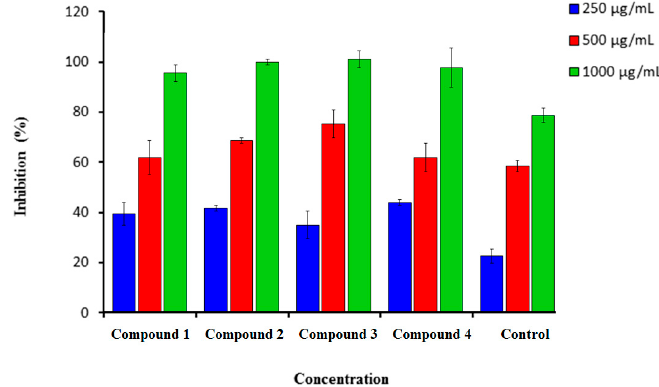
Figure 2. Percentage inhibition of hydrogen peroxide scavenging activity of synthesized compounds ( 1 – 4 ) in comparison to Vitamin C. n = 3. Error bars indicate standard deviation.